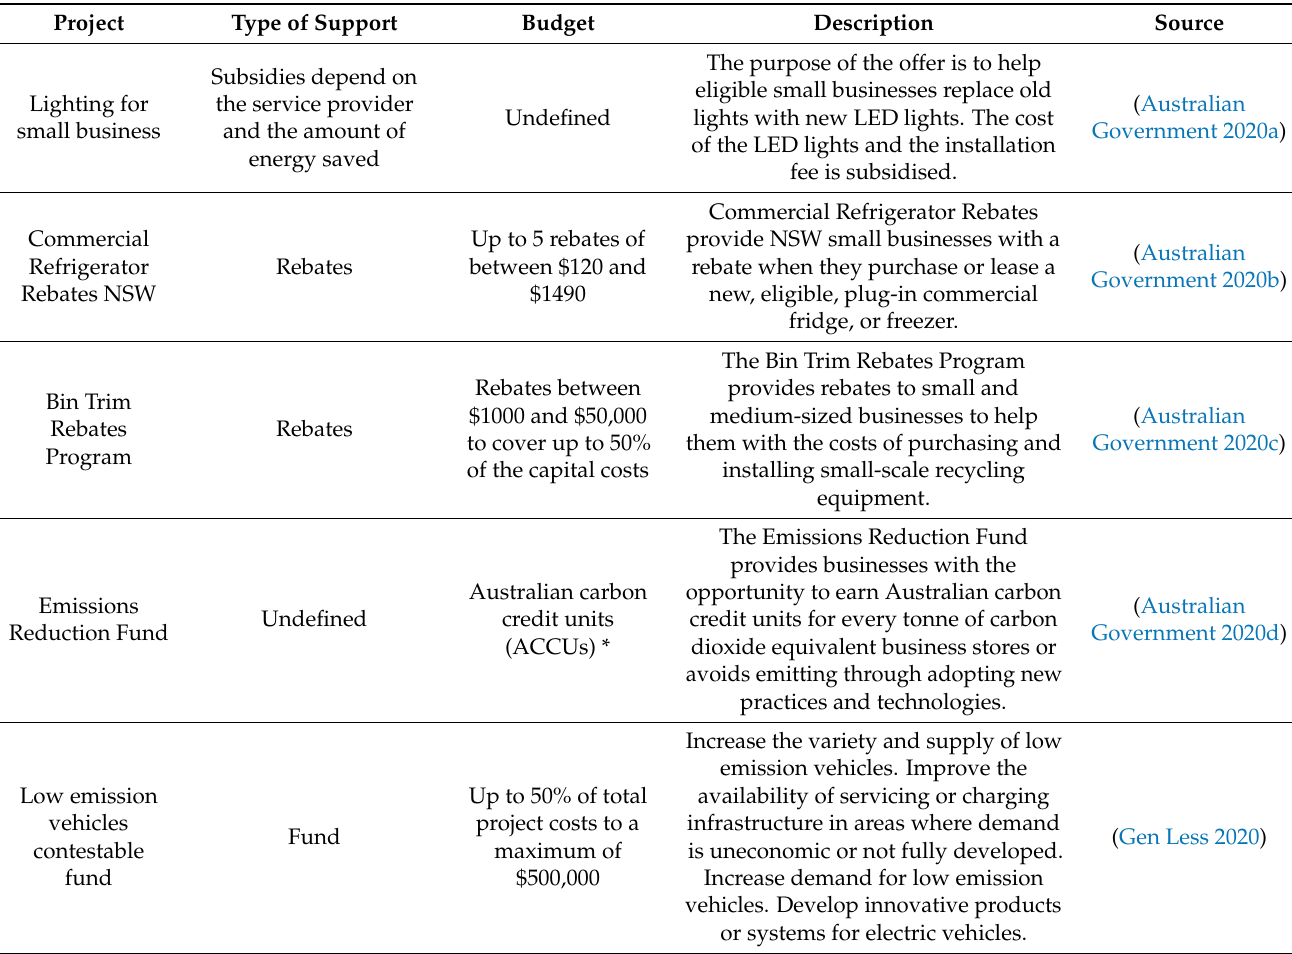
Table 2. Examples of responsible financing projects in Australia and New